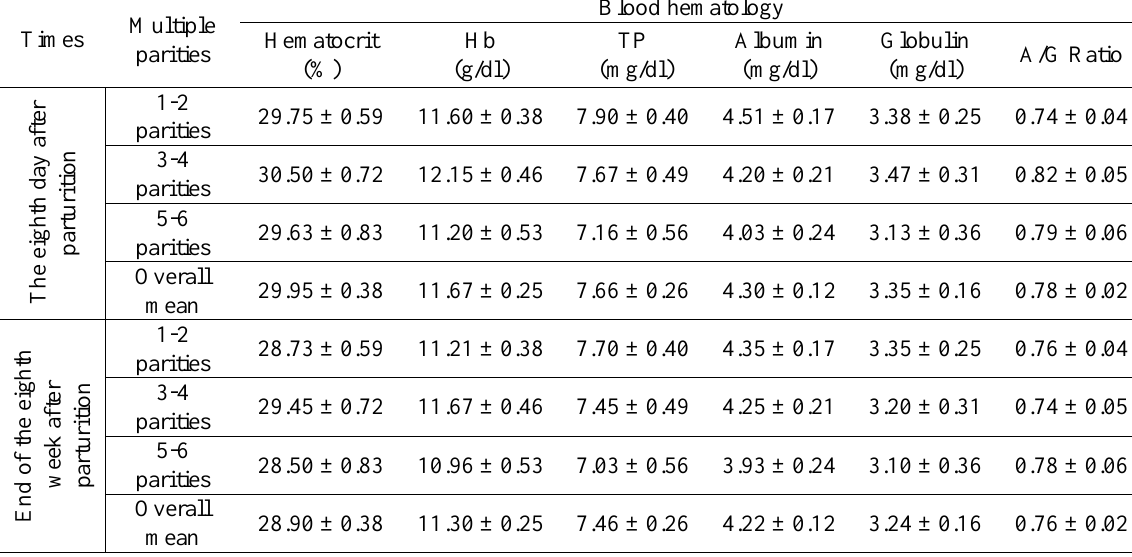
Table 1: The variation (mean ± S.E) of Maghrebi she–camels blood hematology measurements among parities in the first and eighth weeks after parturition